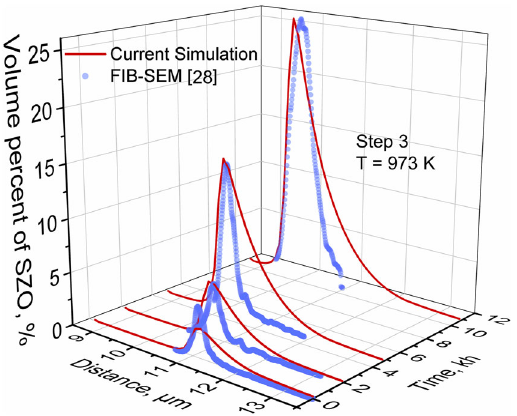
Fig. 3 Simulated and measured SZO formation at the oxygen electrode – electrolyte interface (screen-printed CGO). Amount of formed SZO after different operation time in the case of screen- printed CGO barrier layer predicted from 1D kinetic modeling (red solid lines), compared with the FIB-SEM investigation (blue dotted lines) 28